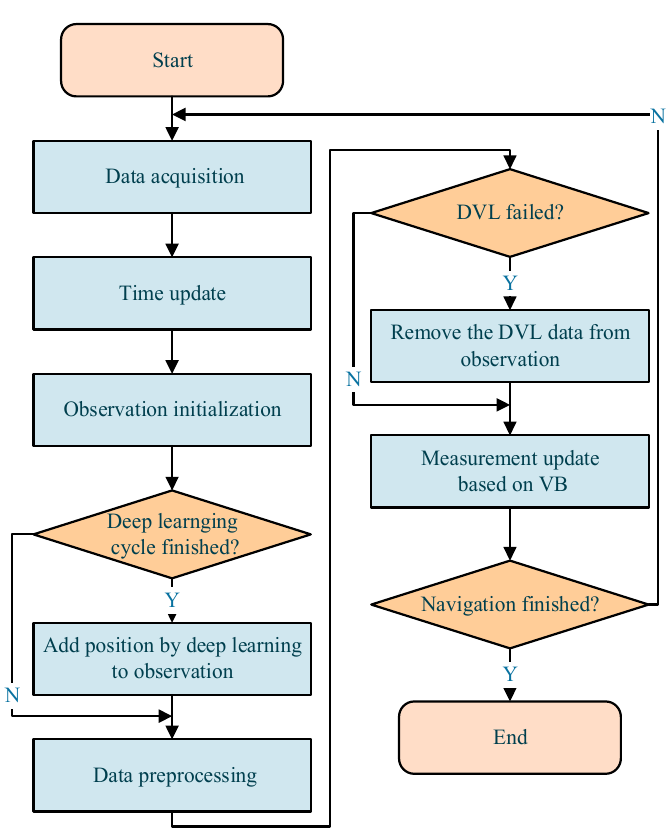
Figure 2. Flowchart of the developed algorithm.